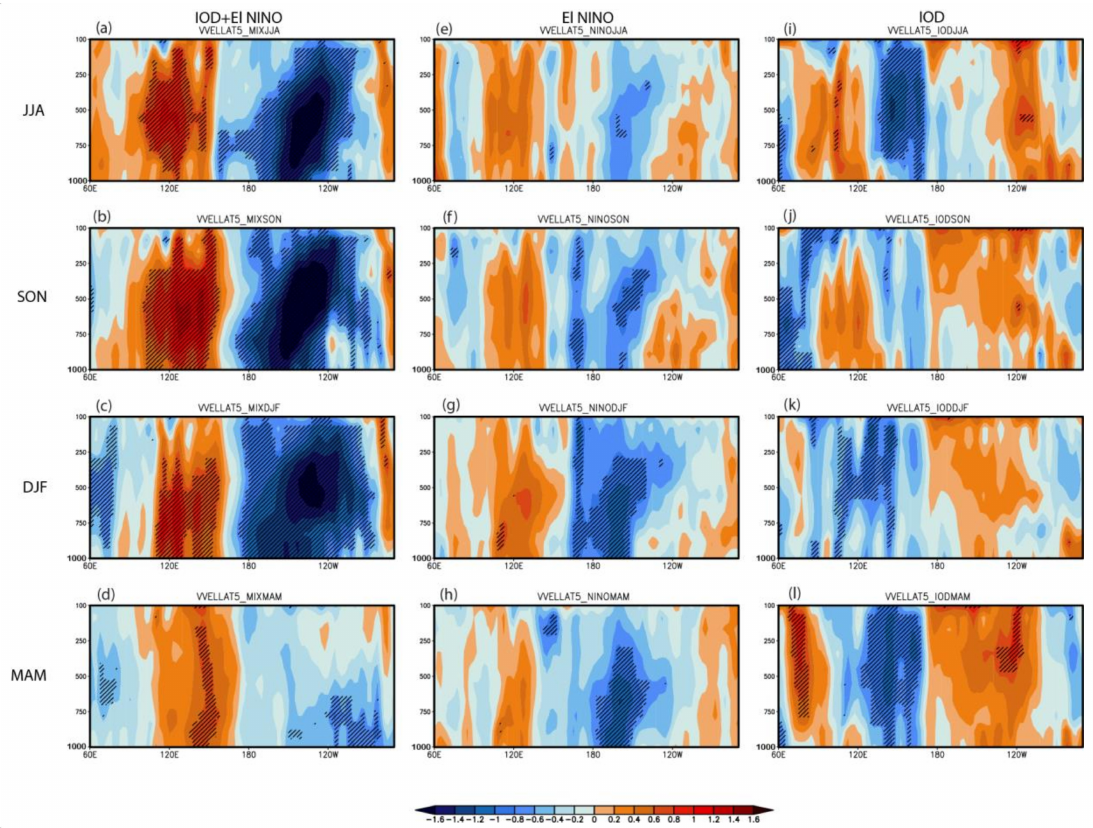
Figure 8. The composite of vertical velocity averaged from − 5 ◦ S to − 5 ◦ N for the events listed in Table 1. The hatched area indicates significance at 95% level. The y -axis is pressure level in